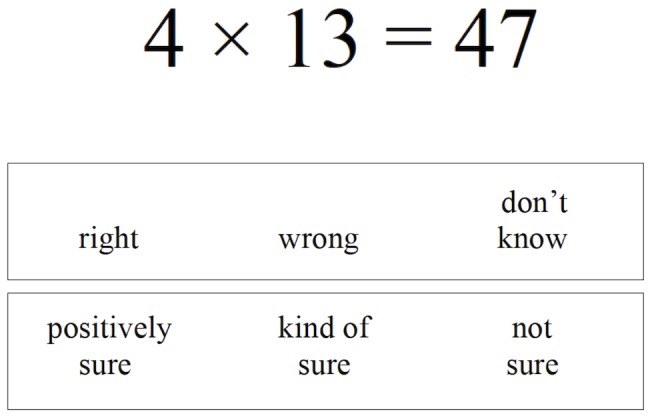
Sample PVT stimulus.